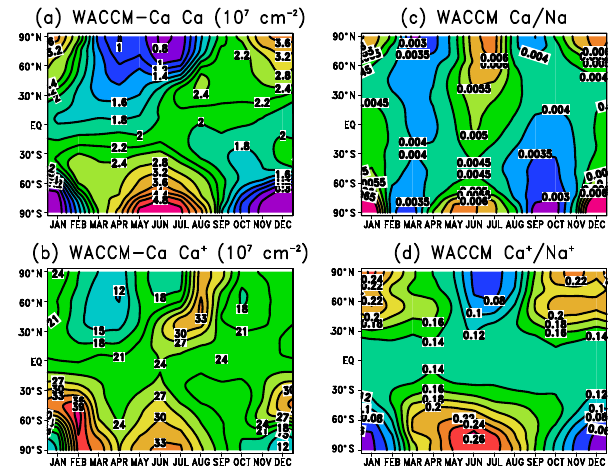
Figure 8. Diurnally averaged column abundances predicted by WACCM, plotted as a function of latitude and month: (a) Ca, (b) Ca + , (c) ratio of Ca / Na, and (d) ratio of Ca + / Na +